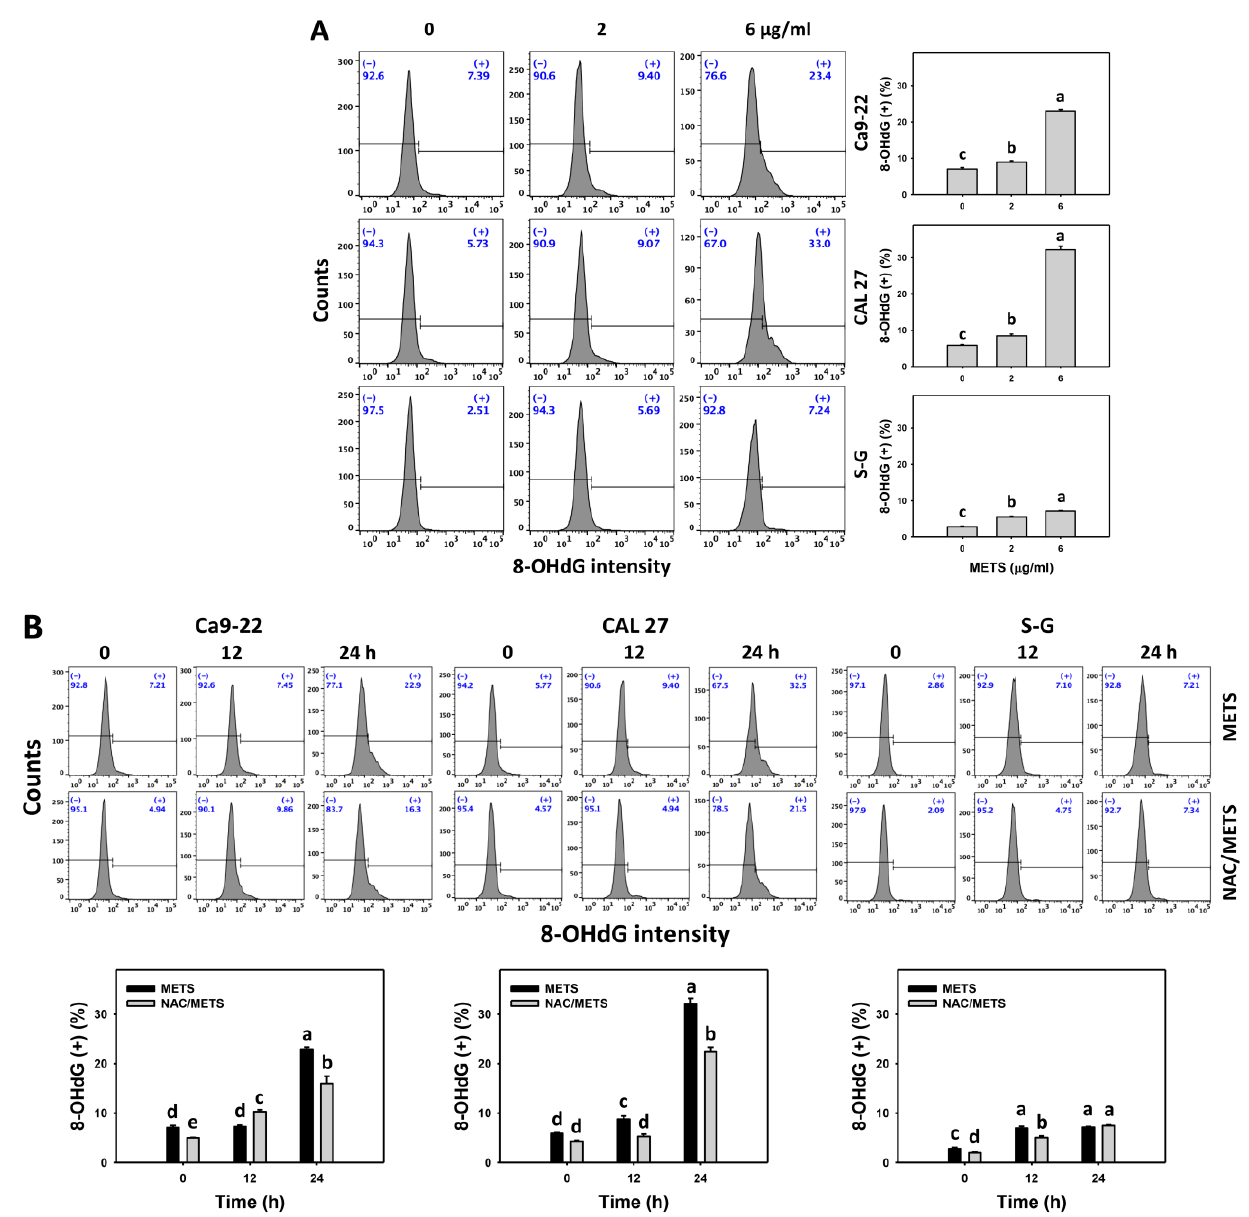
Figure 10. METS enhances the 8-OHdG level of oral cancer cells. ( A ) 8-OHdG histogram changes. Cells were treated with METS for 24 h. Oral cancer and normal cells (S-G) were included. (+) indicates the high intensity of 8-OHdG. ( B ) NAC response on 8-OHdG levels. Untreated control and NAC pretreatment were followed by posttreatment of vehicle control and METS (6 μg /mL) for 0, 12, and 24 h, i.e., control, NAC, METS, and NAC/METS, respectively. Data = mean ± SD ( n = 3). Data showing non-overlapping lower-case letters have significant results ( p < 0.05) as analyzed by the one-way ANOVA analysis and post hoc test.